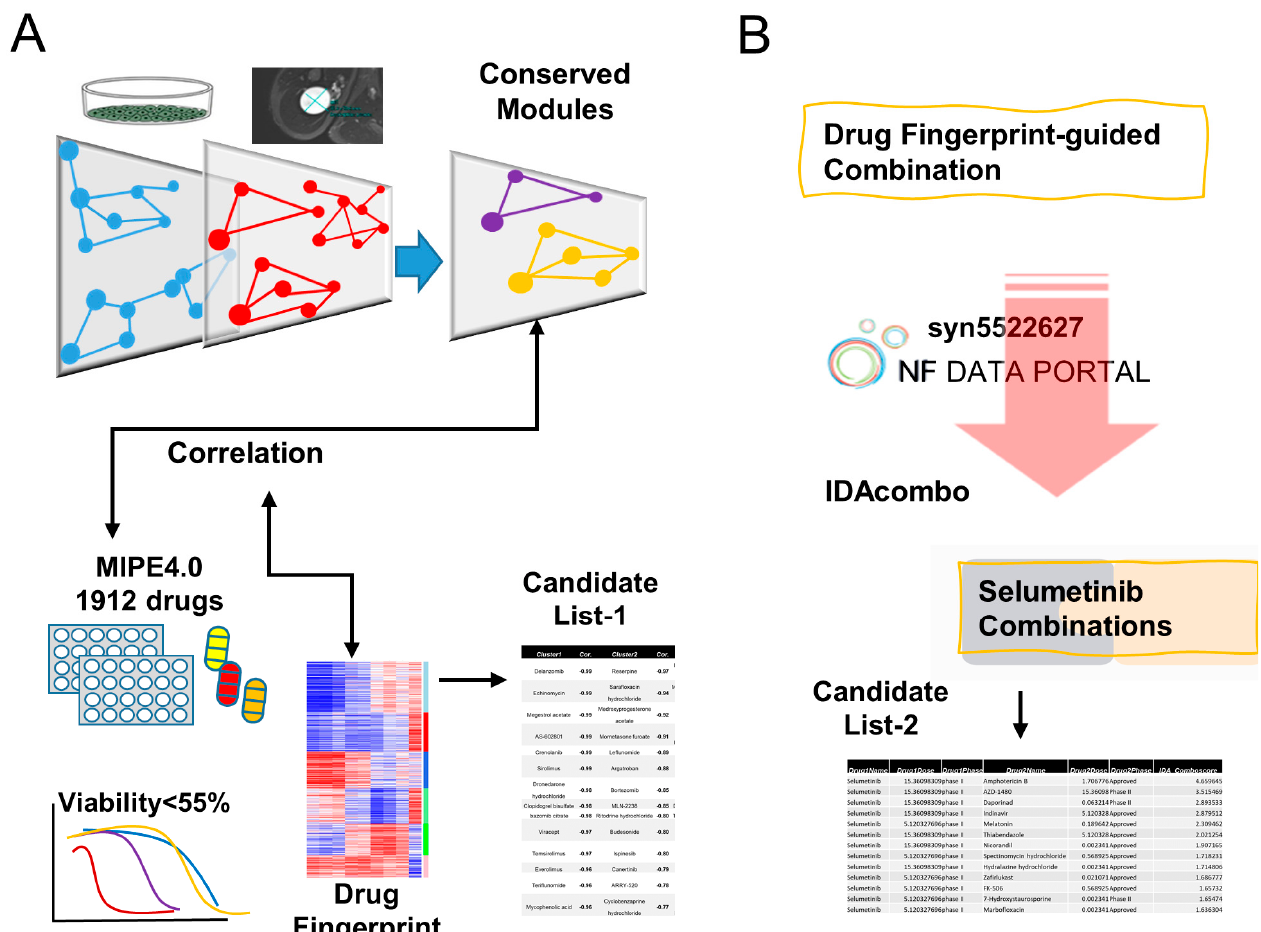
Figure 1. Analysis pipeline to prioritize candidates and drug combinations. ( A ) Conserved gene expression network modules were constructed by cross-referencing the transcriptomes of immortalized human PN cells against resected PN tumors. Drugs that reduced the median viability of cell lines by more than 55% from the MIPE 4.0 library were selected for further analysis. Correlations